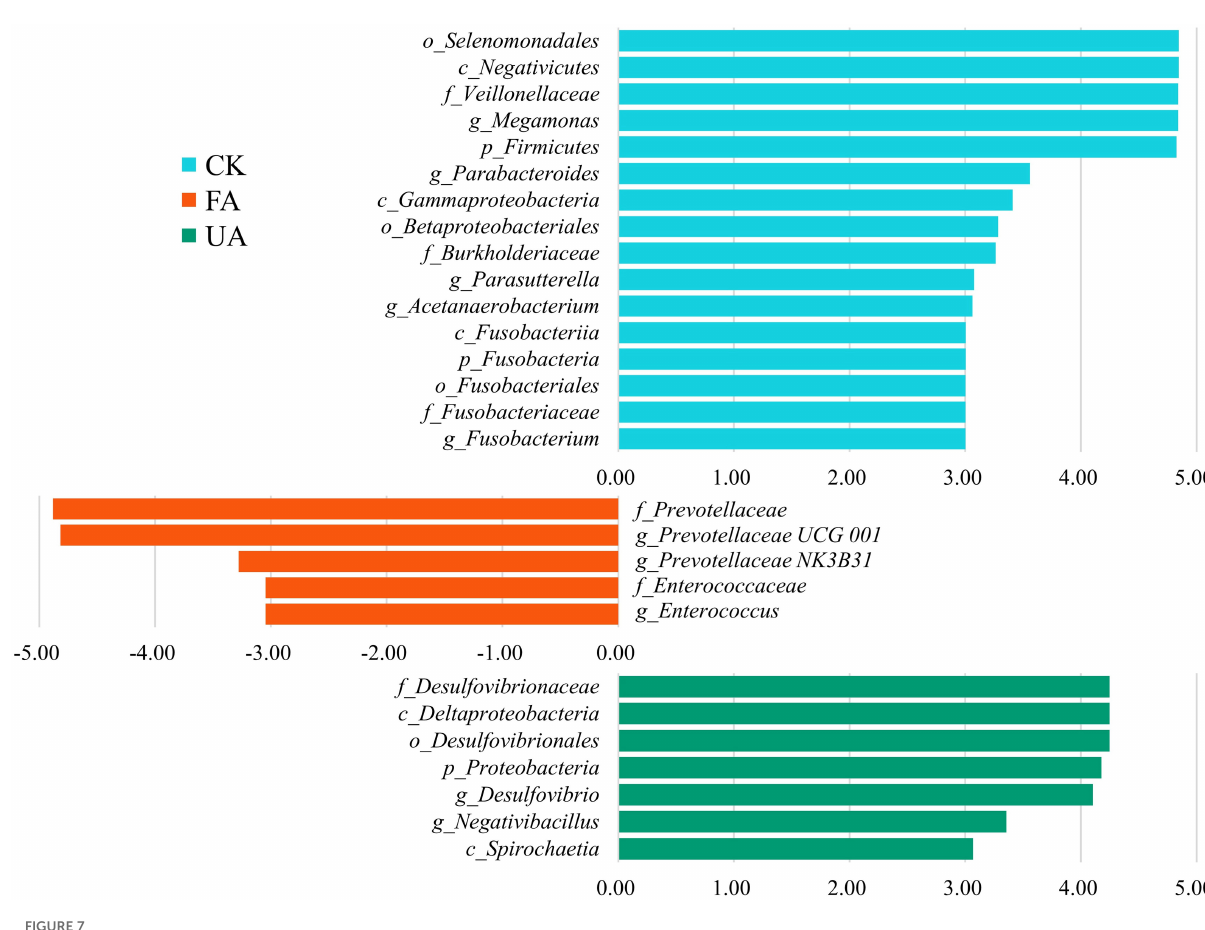
FIGURE7 LEfSe analyses between each feeding group and CK group. Here, the LDA threshold was 3, and the Wilcoxon test was